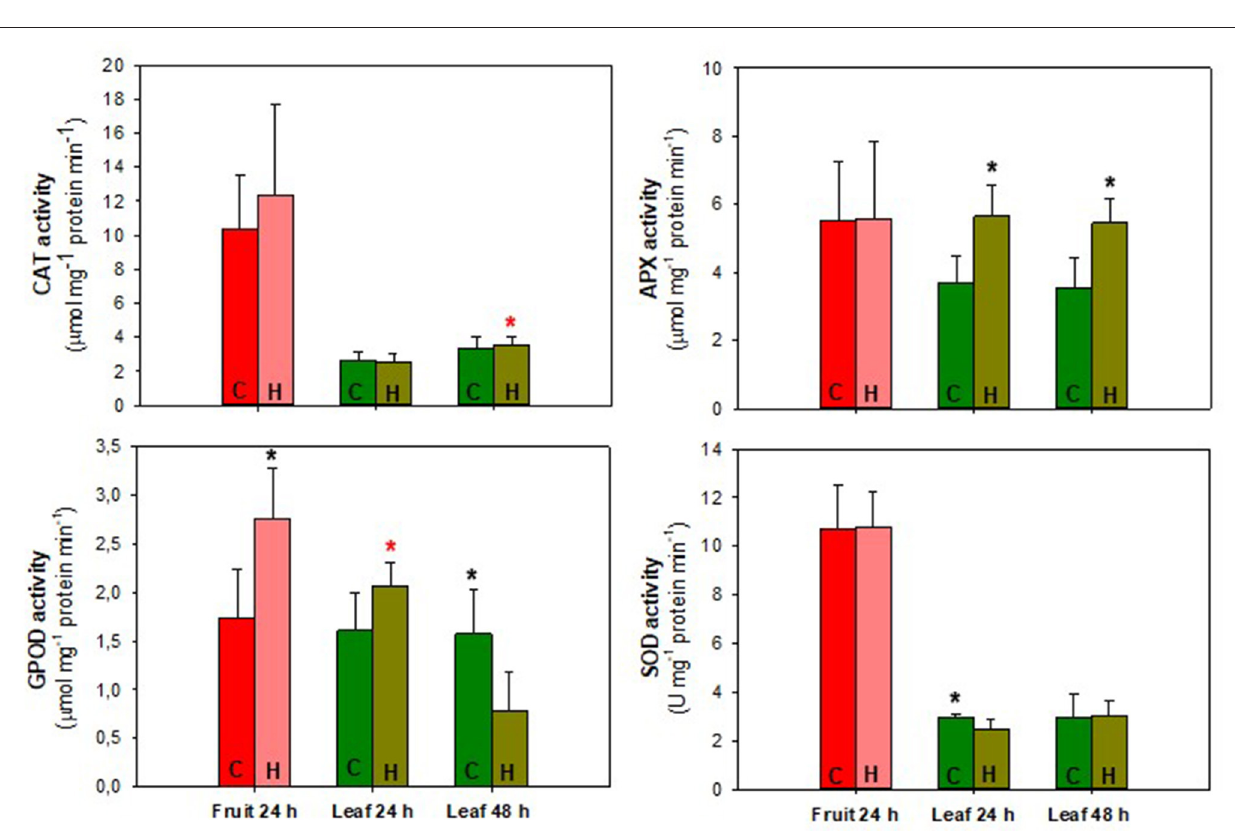
FIGURE 8 | Antioxidant enzymes activity of “Micro-Tom” tomato fruit and leaves during 24/48h of herbivory treatment ( H. armigera ). Values represent the mean ± SD ( n = 5). Black * represents statistical difference between control and herbivory 24h or control and herbivory 48h. Red * represents statistical difference between control 24 and 48h or herbivory 24 and 48h. C, control treatment; H, herbivory treatment. different stimuli and able to adjust their metabolism (Pedreschi and Lurie, 2015; Reissig et al.,